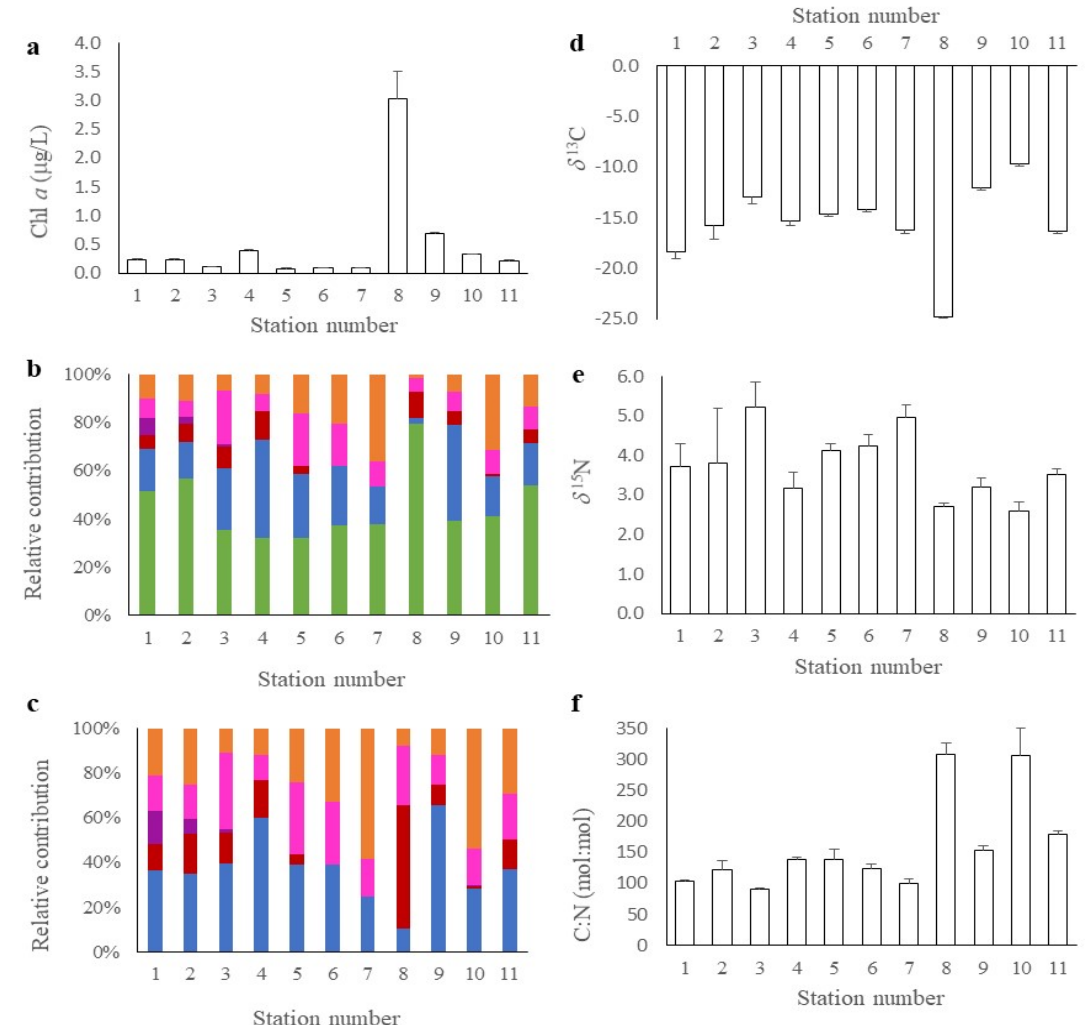
Figure 2. At each of the 11 sampling stations, replicate samples were collected to measure ( a ) Chlorophyll (chl) a (µg L − 1 ); ( b ) HPLC pigment analysis of the phytoplankton community with chlorophytes (green), cyanobacteria (blue), dinoflagellates (red), cryptophytes (pink), haptophytes (purple) and diatoms (orange); and ( c ) HPLC pigment analysis minus the chlorophytes. Simultaneously, we sampled replicates to determine the ( d ) δ 13 C; ( e ) δ 15 N; and ( f ) C:N (mol:mol) of phytoplankton at each of the stations.